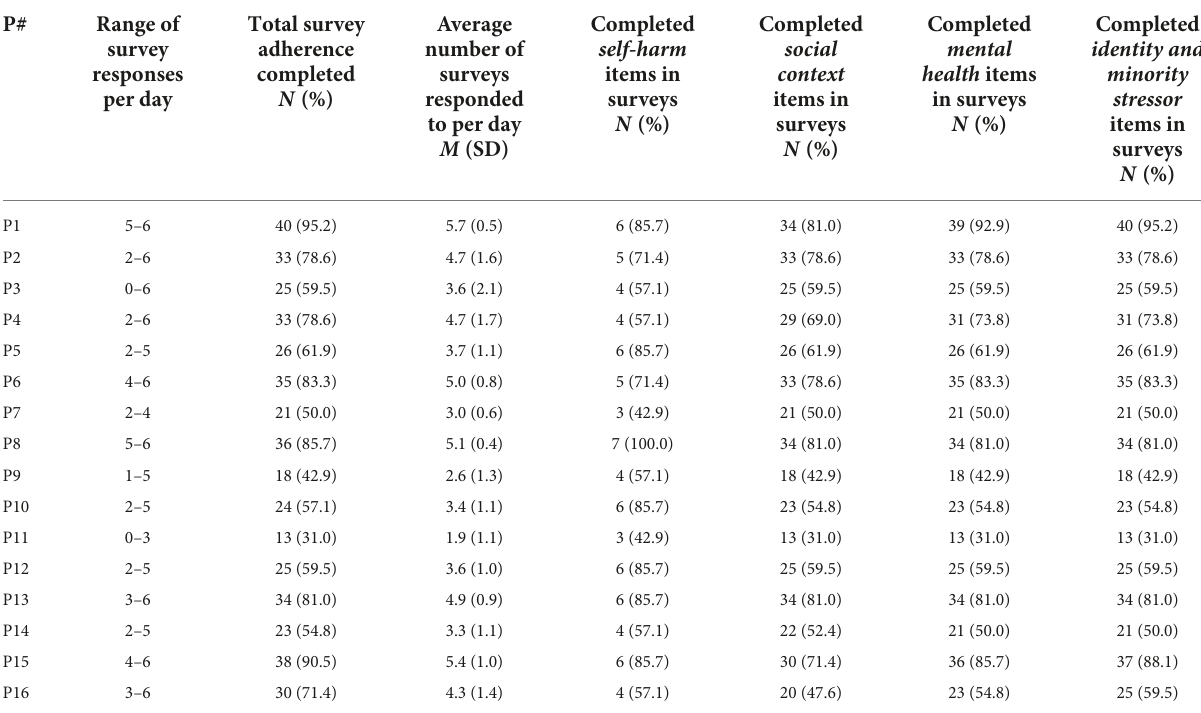
TABLE 4 Participant adherence by total experience sampling method (ESM) survey adherence and ESM item group adherence; range, percentage, mean, and standard